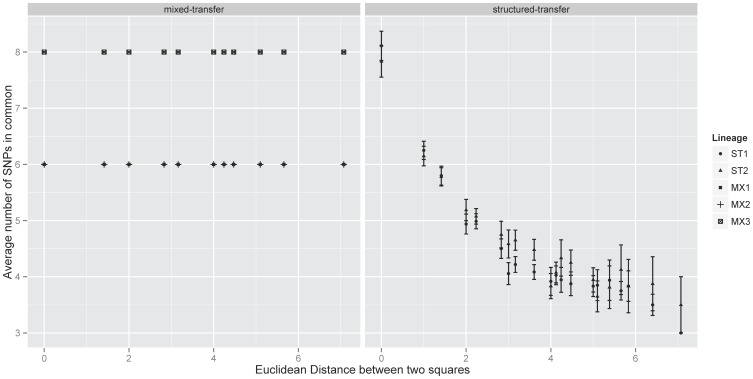
Mean number of substitutions shared by a pair of squares as distance between squares increases.For MX populations, each substitution was found across the entire plate, resulting in a lack of dependence on distance between squares when comparing shared substitutions. This suggests a single dominant lineage on each MX plate. In ST populations the patchy nature of substitutions is reflected in the decay in similarity with distance. This is consistent with multiple lineages dispersed over short distances on ST plates.